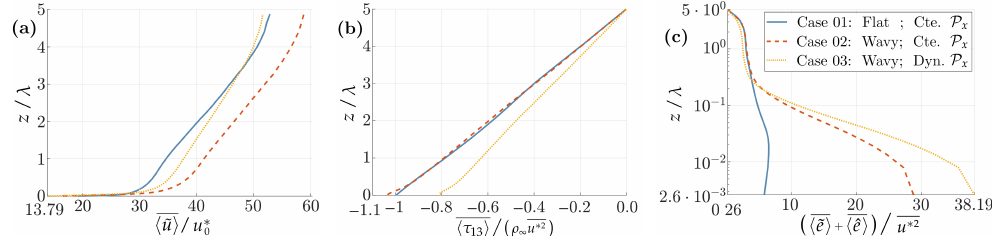
Figure 4. Height-dependent wind and turbulence profiles averaged with t avg = 75 T 0 . Pilot applica- tion. ( a ) longitudinal velocity; ( b ) total shear stress; ( c ) total turbulent kinetic energy